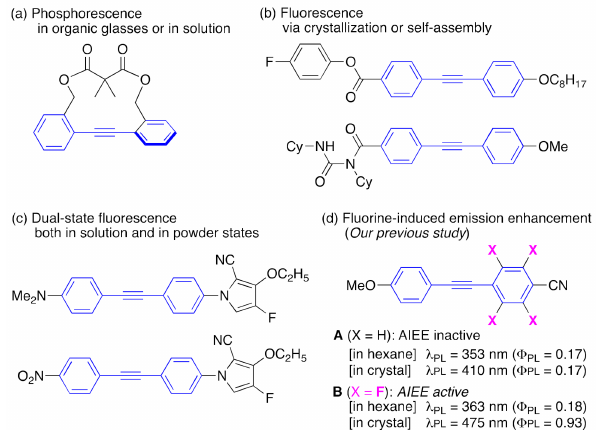
Figure 1. Tolane-based luminescent molecules reported in the literature: ( a ) twist tolanes showing phosphorescence in organic glasses or in solution, ( b ) donor- π -acceptor-type tolanes displaying fluorescence via crystallization or self-assembly, ( c ) tolanes exhibiting dual-state fluorescence, and ( d ) non-fluorinated or fluorinated tolanes-based fluorophores. Abbreviation: AIEE: aggregation-induced emission enhancement.